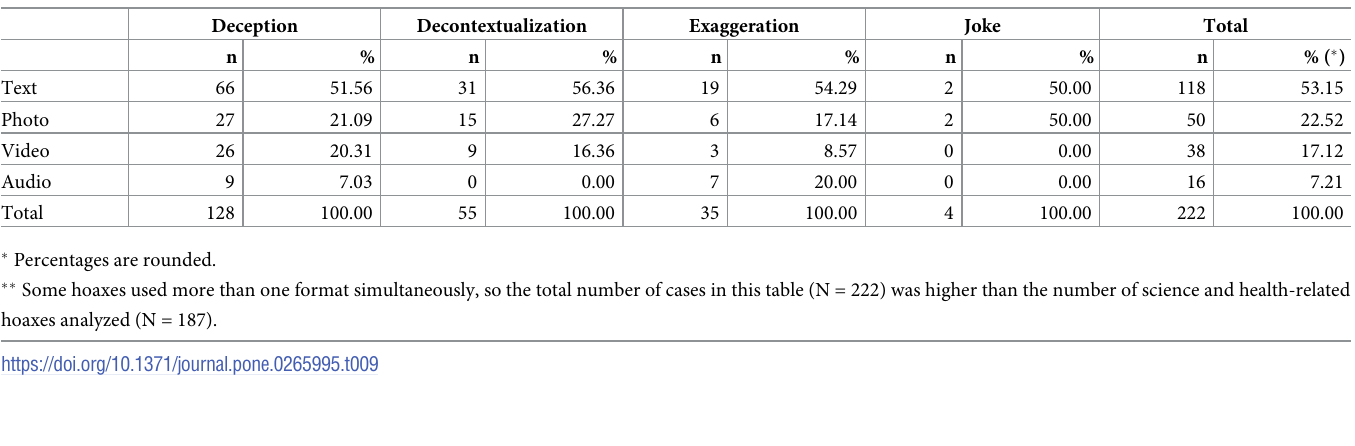
Table 9. Types of hoaxes, according to format ( ��